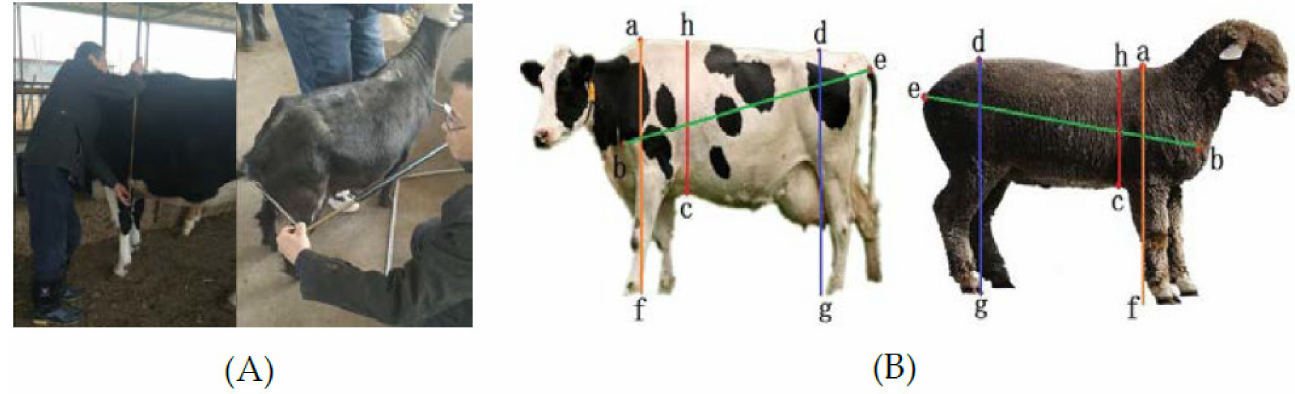
Figure 2. ( A ) Manual measurement of cattle and goat body dimensions; ( B ) Illustration of four measured body dimensions: Line ( a , f ) is withers height, line; ( b , e ) is body length, line; ( c , h ) is chest depth line; ( d , g ) is hip